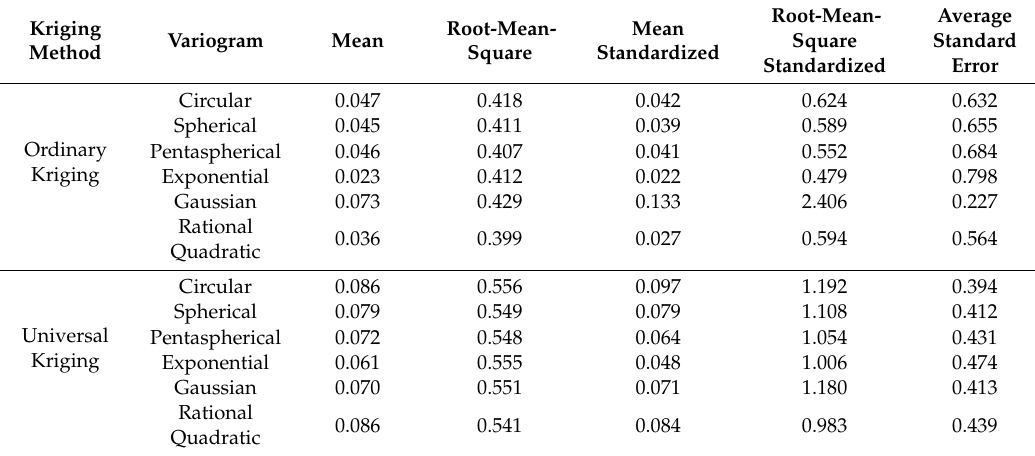
Table 2. Kriging interpolation with di ff erent semi-variogram